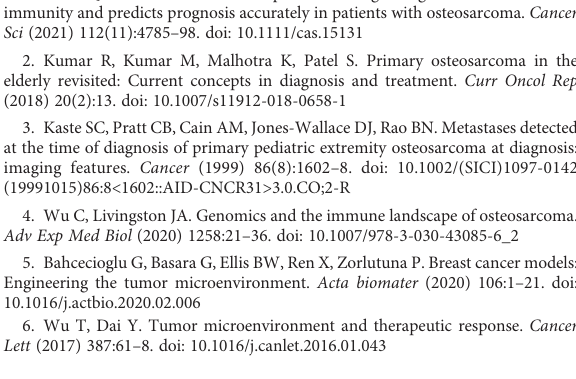
SUPPLEMENTARY FIGURE S1 Immune cell expression offour B-cell marker genes. (A) RPL37A. (B) MEF2C. (C) PLD3. (D) SNX2. SUPPLEMENTARY FIGURE S2 Principal component analysis. (A) TCGA. (B) GSE21257. SUPPLEMENTARY FIGURE S3 GSE21257 tumor microenvironment between the high-risk and low-risk groups. (A) Boxplots depicting the CIBERSORT scores of 22 immune cells of the high-risk patients compared to low-risk patients. (B) Boxplots depicting the 29 immune signature ssGSEA scores of the high-risk patients compared to low-risk patients. (C – F) Comparisons between the 2 groups in terms of stomal score, immune score, estimate score, and tumor purity. (G) Expression of ICB-related genes in high- and low- risk groups. SUPPLEMENTARY FIGURE S4 B cells in GSE21257 data in relation to prognosis. (A) Heatmap depicting the correlation between 4-gene mRNA expressions with the 22 immune cells. (B – D) Correlation fi tted curves of risk scores with activated B cells, immature B cells, and memory B cells. (E – G) Survival curves grouped by median content of activated B cells, immature B cells and memory B cells,